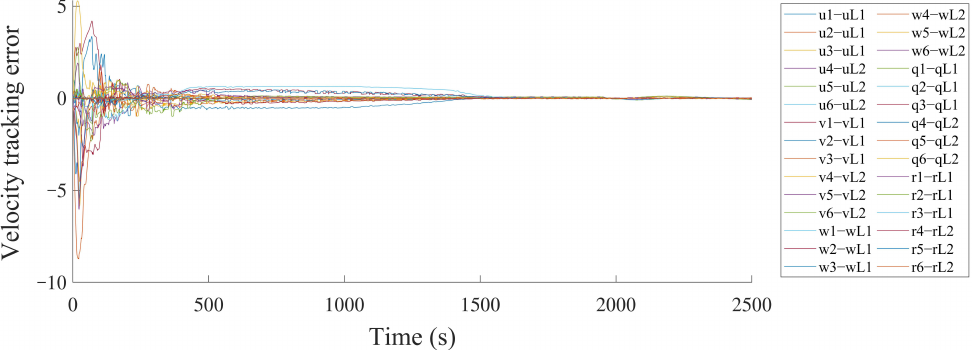
Figure 14. The velocity tracking errors of a multiple stochastic AUV system in a contrast